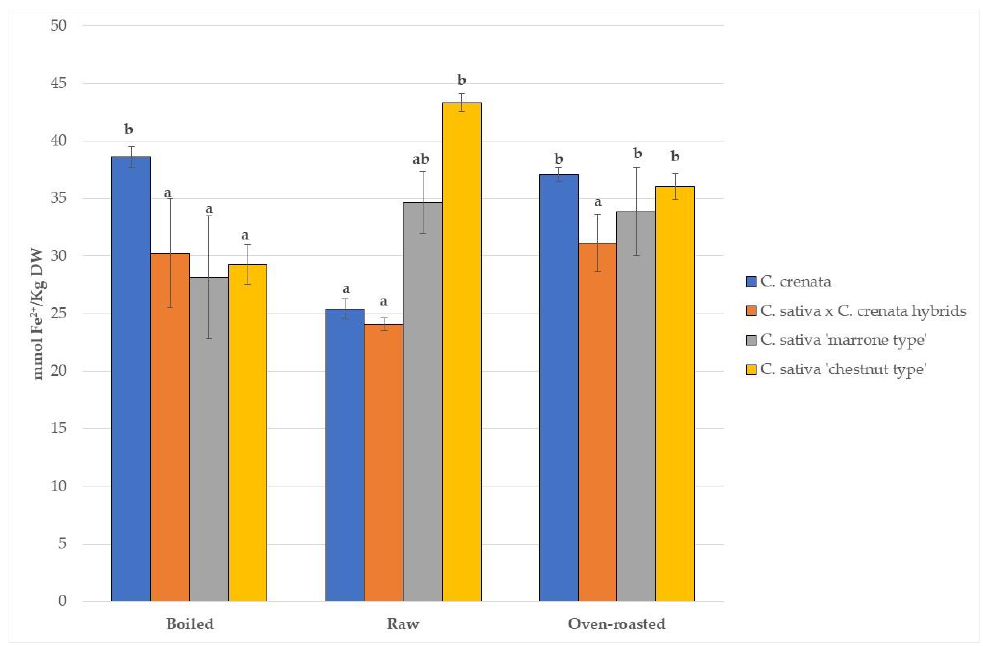
Figure 2. AOCs of the analysed chestnut groups. Different letters for the considered groups indicate significant statistical differences ( p < 0.05) among different species/hybrids in the same “cooking method” groups. Different colours represent the considered genotypes. TPC values significantly ranged from 75.78 ± 8.56 mgGAE 100 g − 1 DW to 200.90 ± 17.50 mgGAE 100 g −1 DW for boiled chestnuts, from 87.09 ± 9.98 mgGAE 100 g −1 DW to 154.30 ± 22.90 mgGAE 100 g −1 DW for oven-roasted chestnuts, and from 68.82 ± 7.89